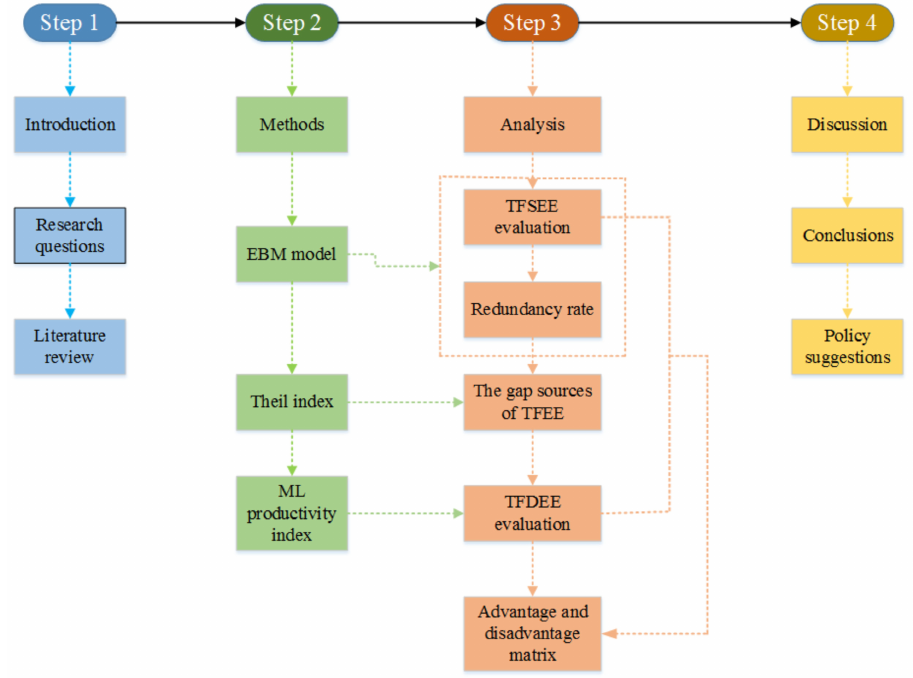
Figure 1. Research framework for this